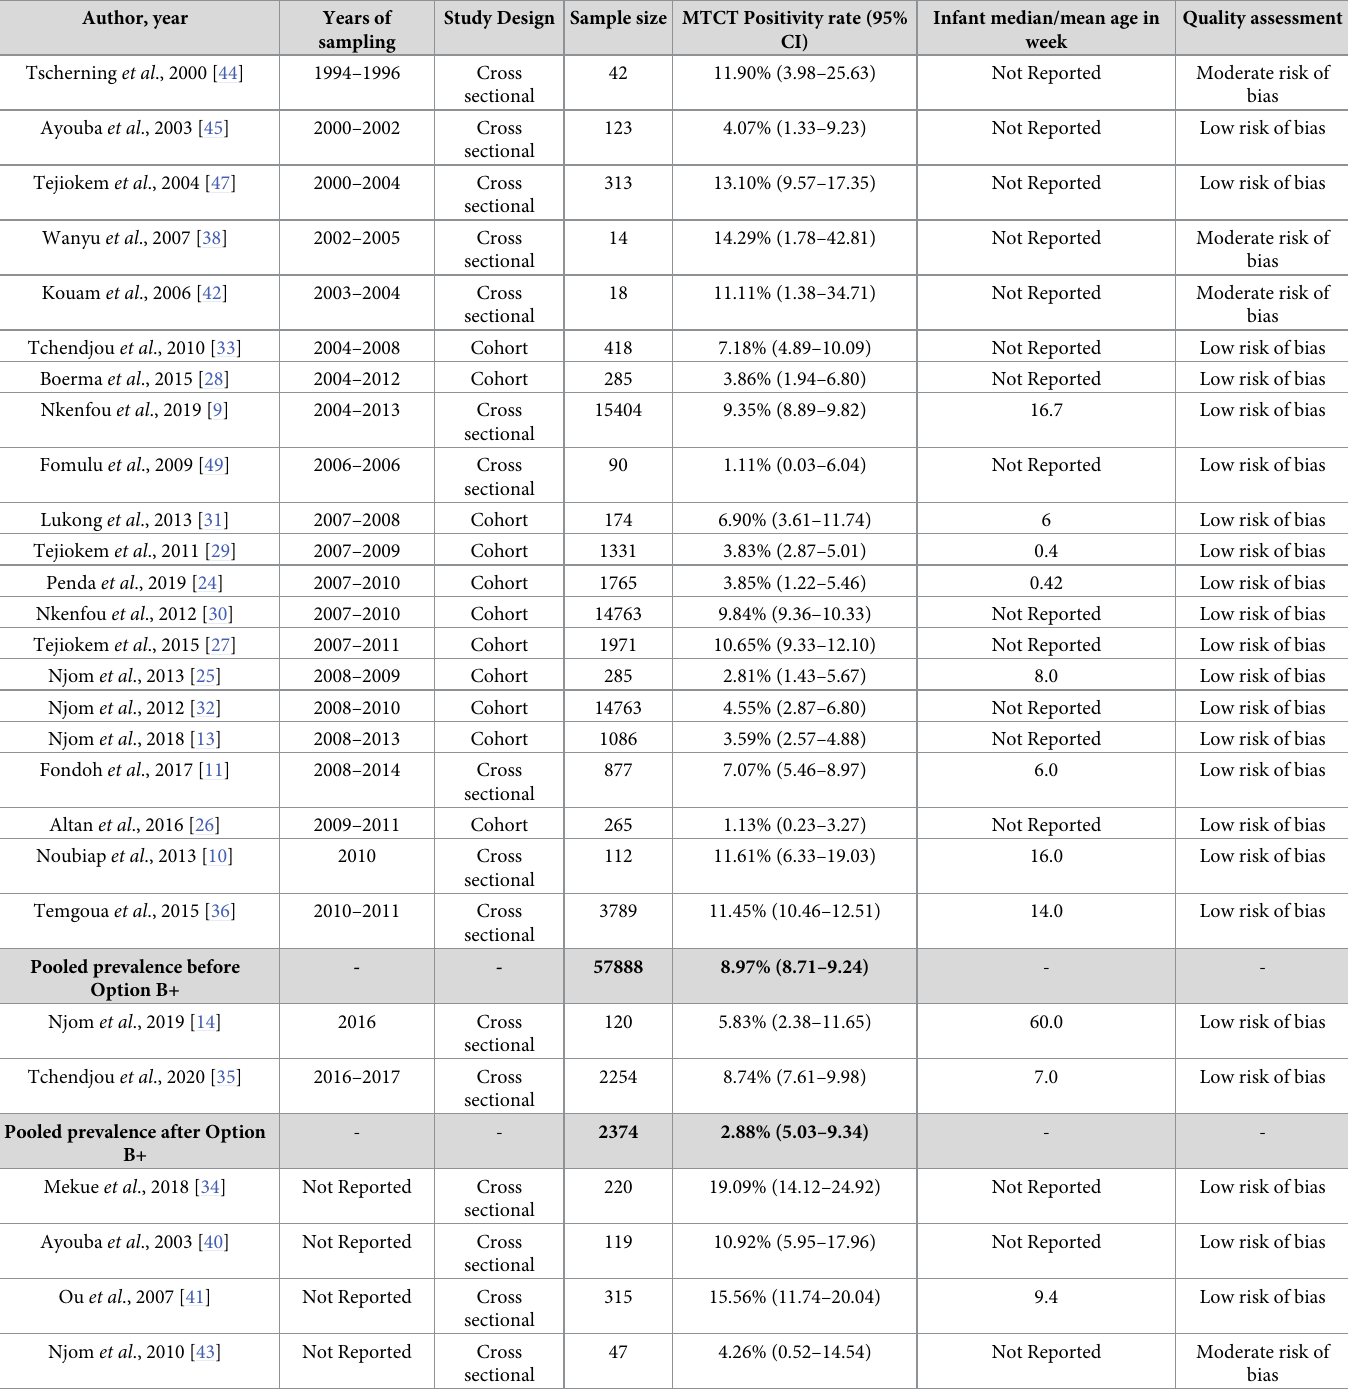
Table 1. General characteristics of the included studies for prevalence of MTCT and quality of